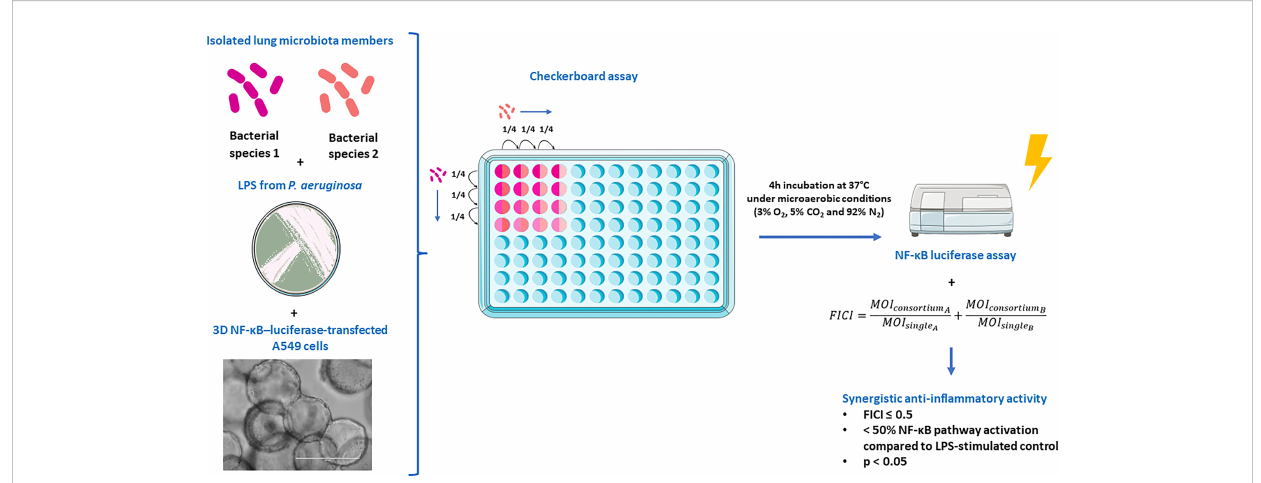
FIGURE 1 Experimental set-up to evaluate synergistic effects on the inhibition of NF- k B pathway activation in 3D NF- k B – luciferase-transfected A549 cells. The fi gure was partly created using the Servier Medical Art, licensed under a Creative Commons Attribution 3.0 unported